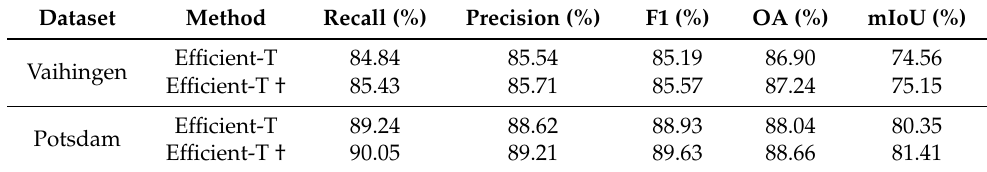
Table 9. Results on Vaihingen and Potsdam datasets, “†” means using IEE and EEE methods.